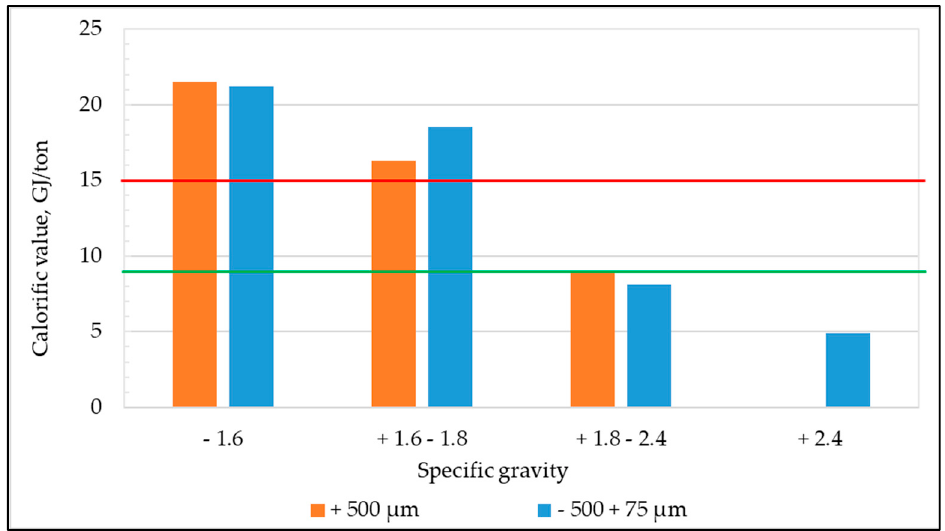
Figure 2. Calorific value of different SG fractions for the coarse and fine sample.